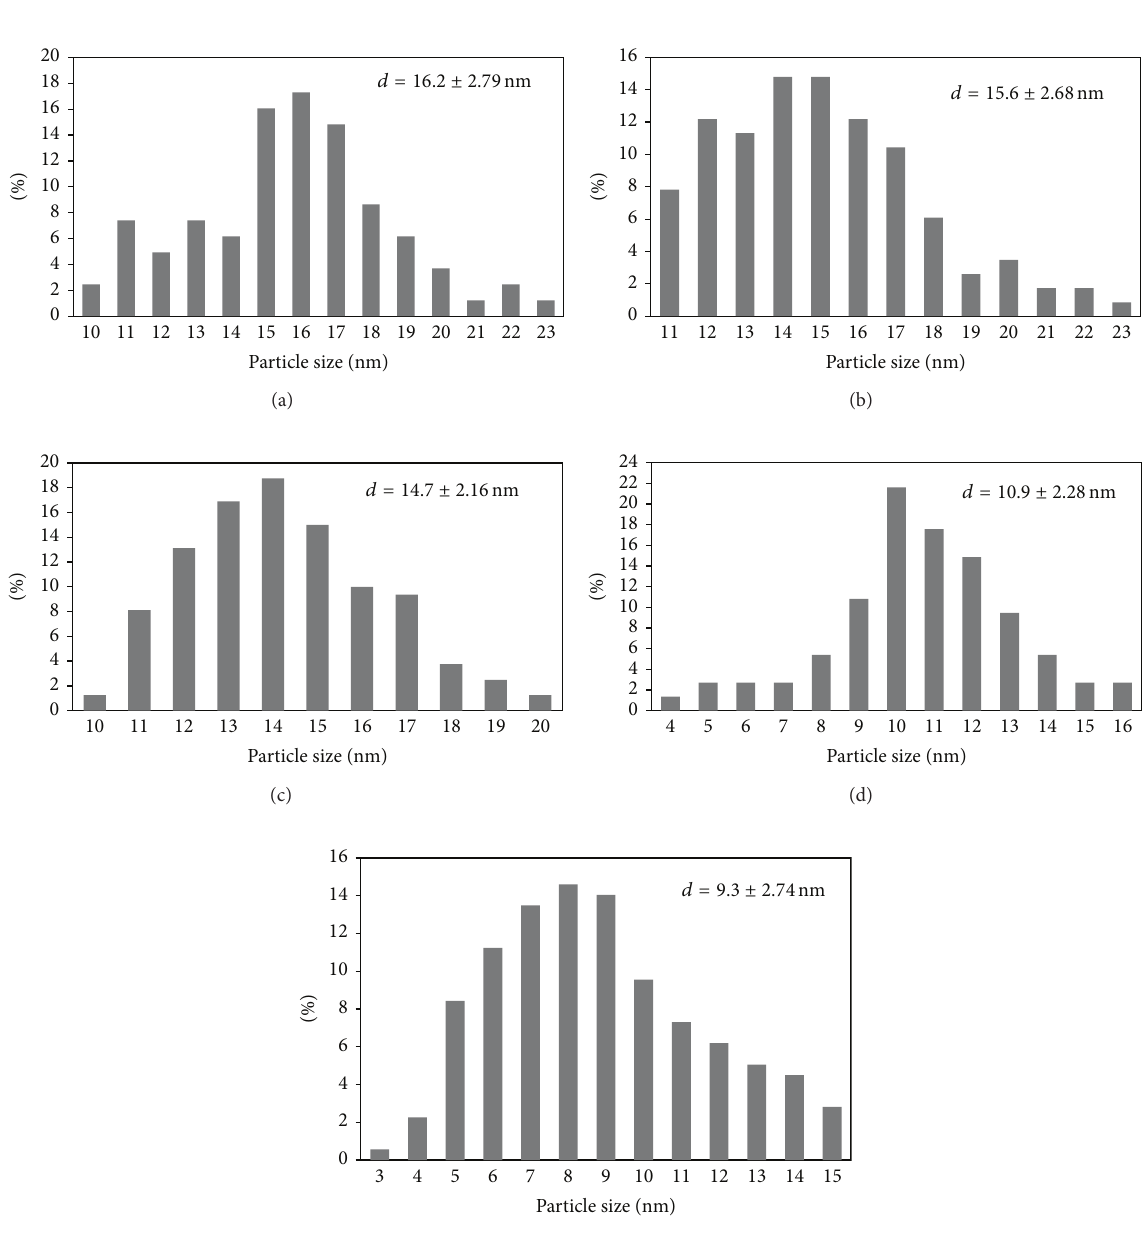
Table 1: Particles size, magnetic property, zeta potential, and temperature stability (T